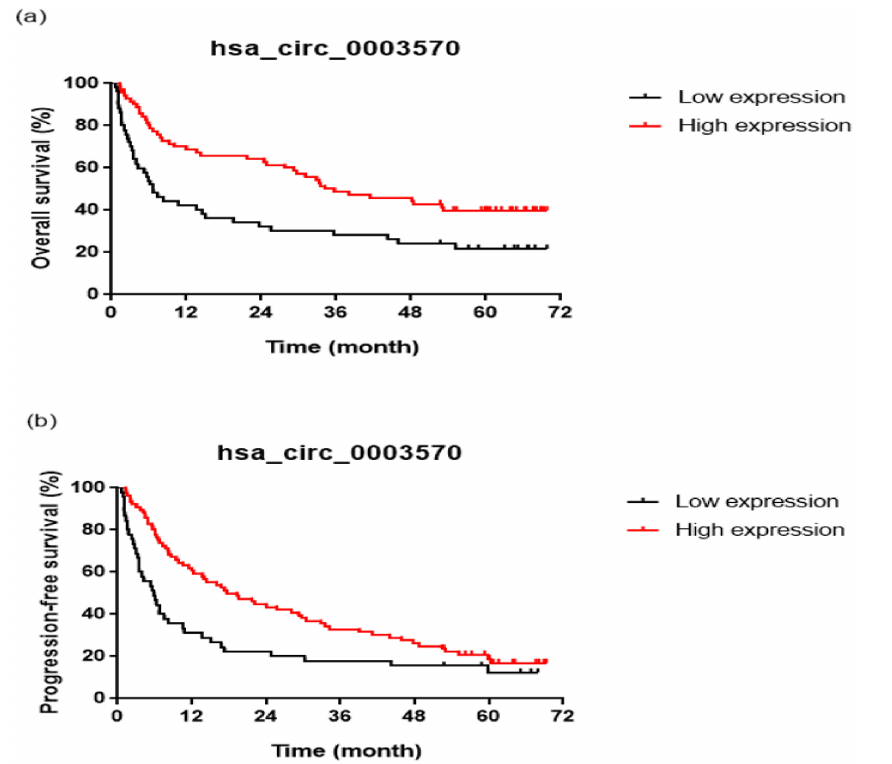
Figure 2. Survival curves according to the hsa_circ_0003570 expression level. Overall survival ( a ) (log-rank test, p = 0.002) and progression-free survival ( b ) (log-rank test, p = 0.007) rates were decreased in the low hsa_circ_0003570 expression level group. Table 4. Prognostic factors for progression-free survival in univariable and multivariable analyses. Univariable Analysis Multivariable Factor